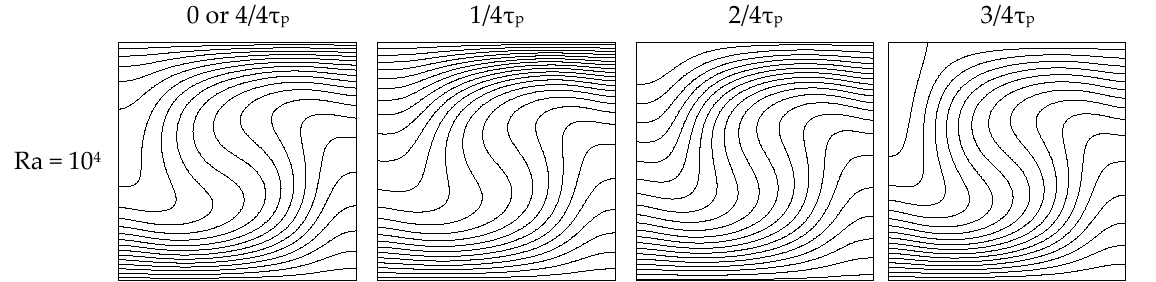
Figure 5. Evolution of streamlines “ Ψ ” over a period as a function of the Rayleigh number (Amp = 0.8 and |f| = 0 × 33 10 − 4 ).